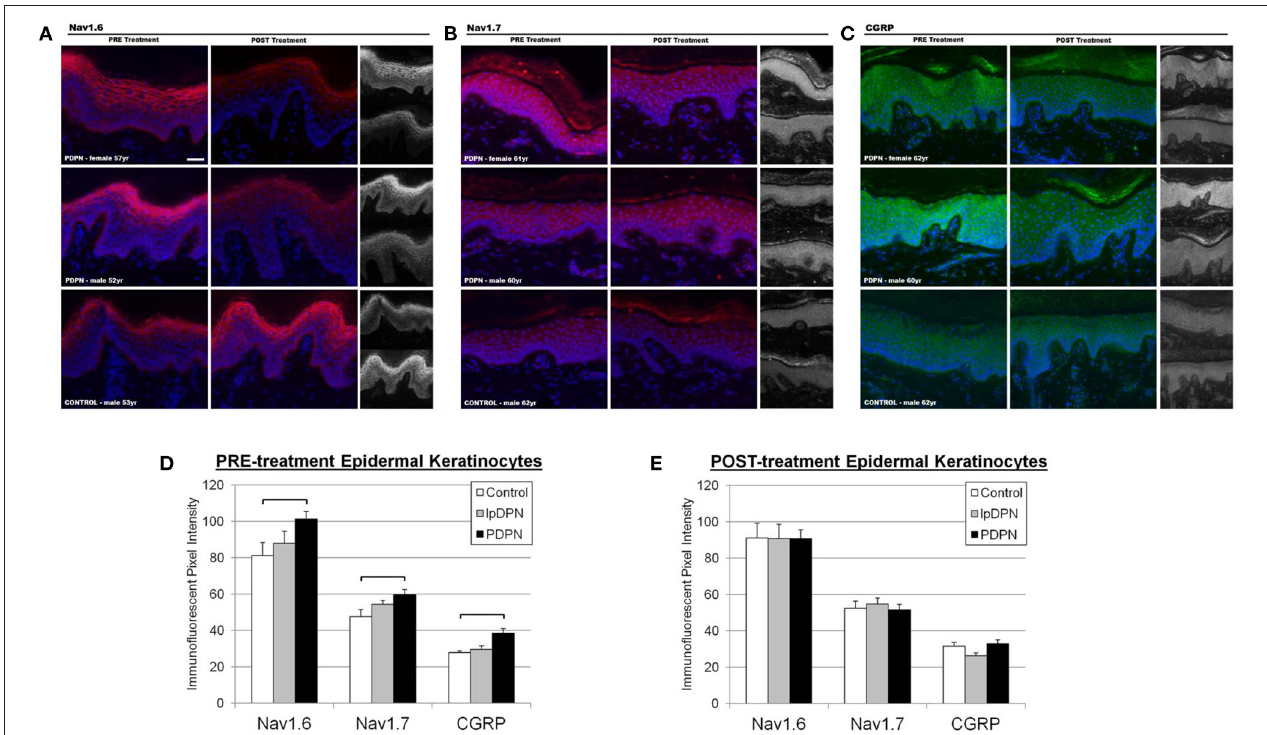
FIGURE 4 | Keratinocyte biomarker immunolabeling. Epidermal keratinocyte biomarkers are significantly increased among PDPN patients compared with control biopsies. The panels depict representative images of immunolabeling for (A) Nav1.6, (B) Nav1.7, and (C) CGRP along with DAPI fluorescence from PRE and POST treatment biopsies, along with half-sized grayscale images used for pixel intensity measures, from age-matched female and male PDPN patients compared to a male control. (D) There was a significant increase in PRE-treatment Nav1.6, Nav1.7, and CGRP immunolabeling among PDPN patients compared with control (brackets indicate significant differences). (E) Topical lidocaine treatment acted to decrease keratinocyte biomarker levels of Nav1.6, Nav1.7, and CGRP among PDPN patients such that no differences were found among the groups